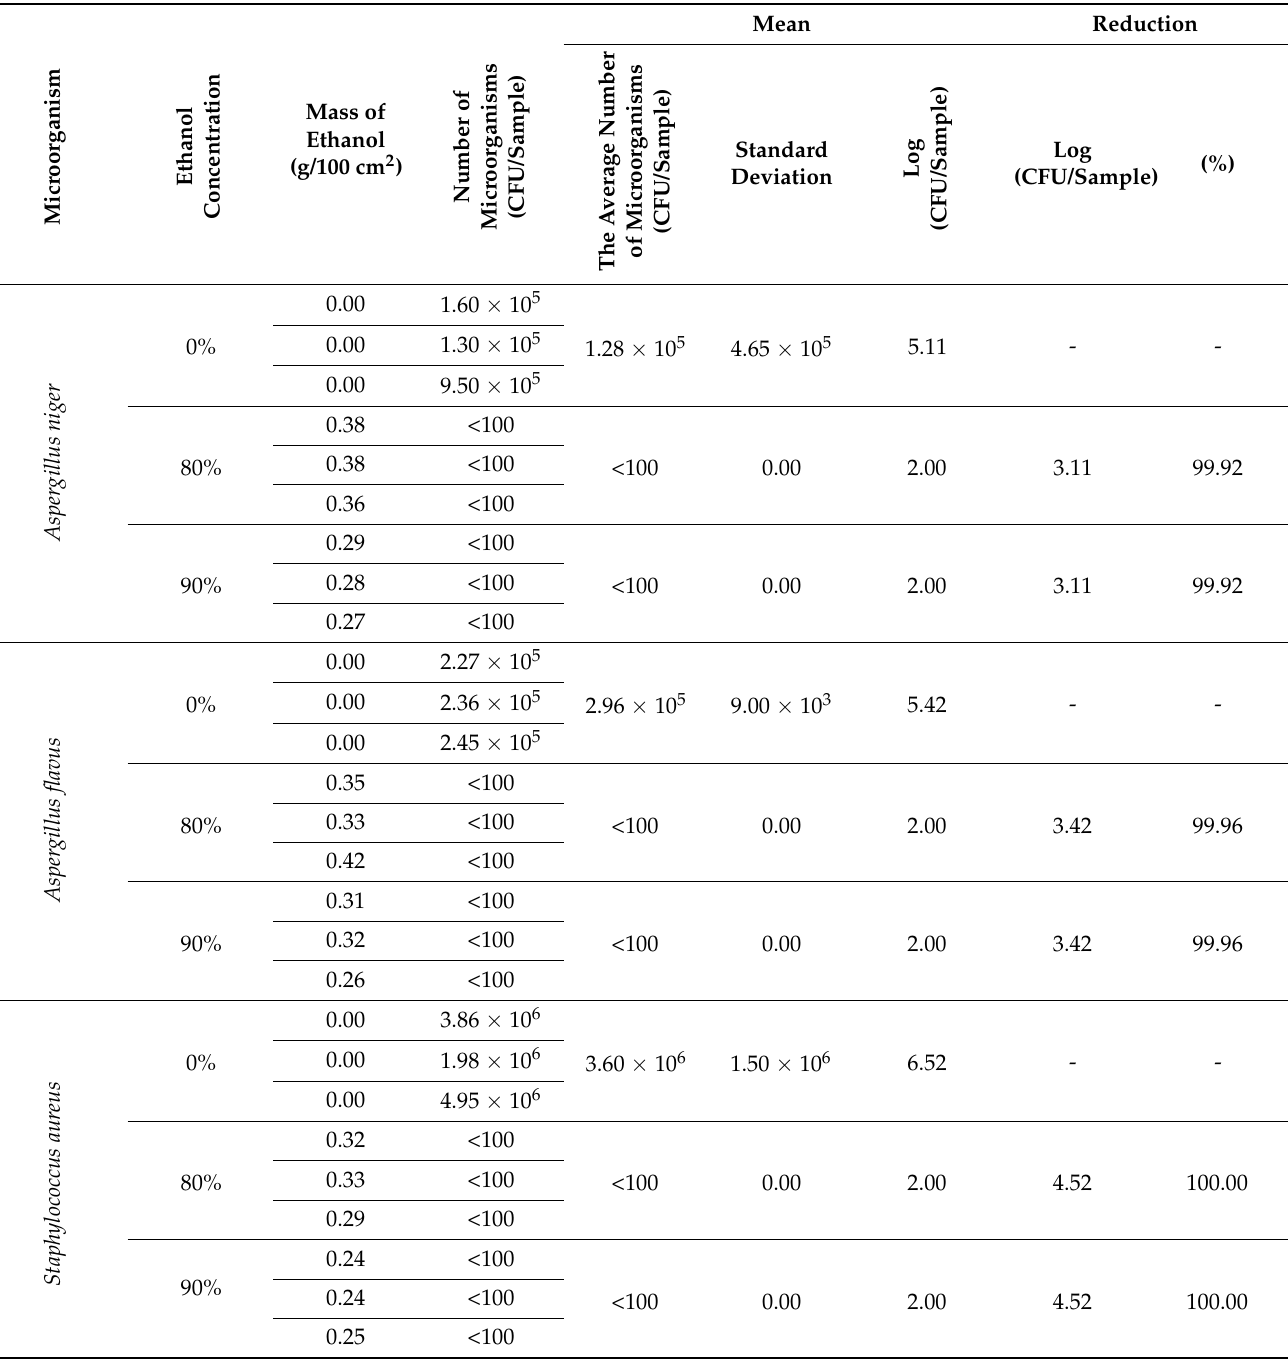
Table 4. Evaluation of the effectiveness of long-term action of ethanol applied for 4 s on a model